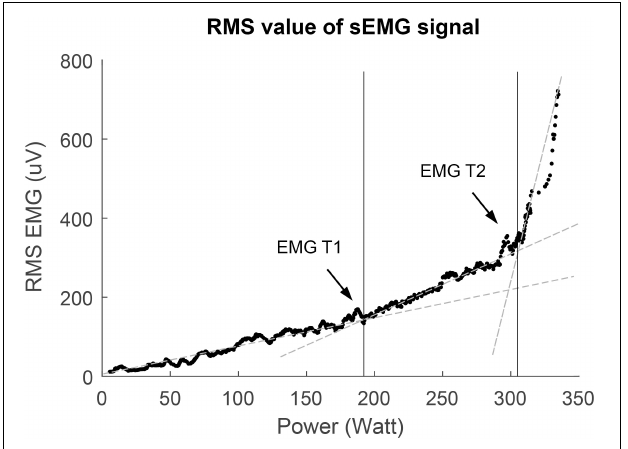
FIGURE 2 | Example of V-slope method used for threshold determination of the first surface EMG threshold (sEMG Th1) and the second surface EMG threshold (sEMG Th2). RMS, root mean square.